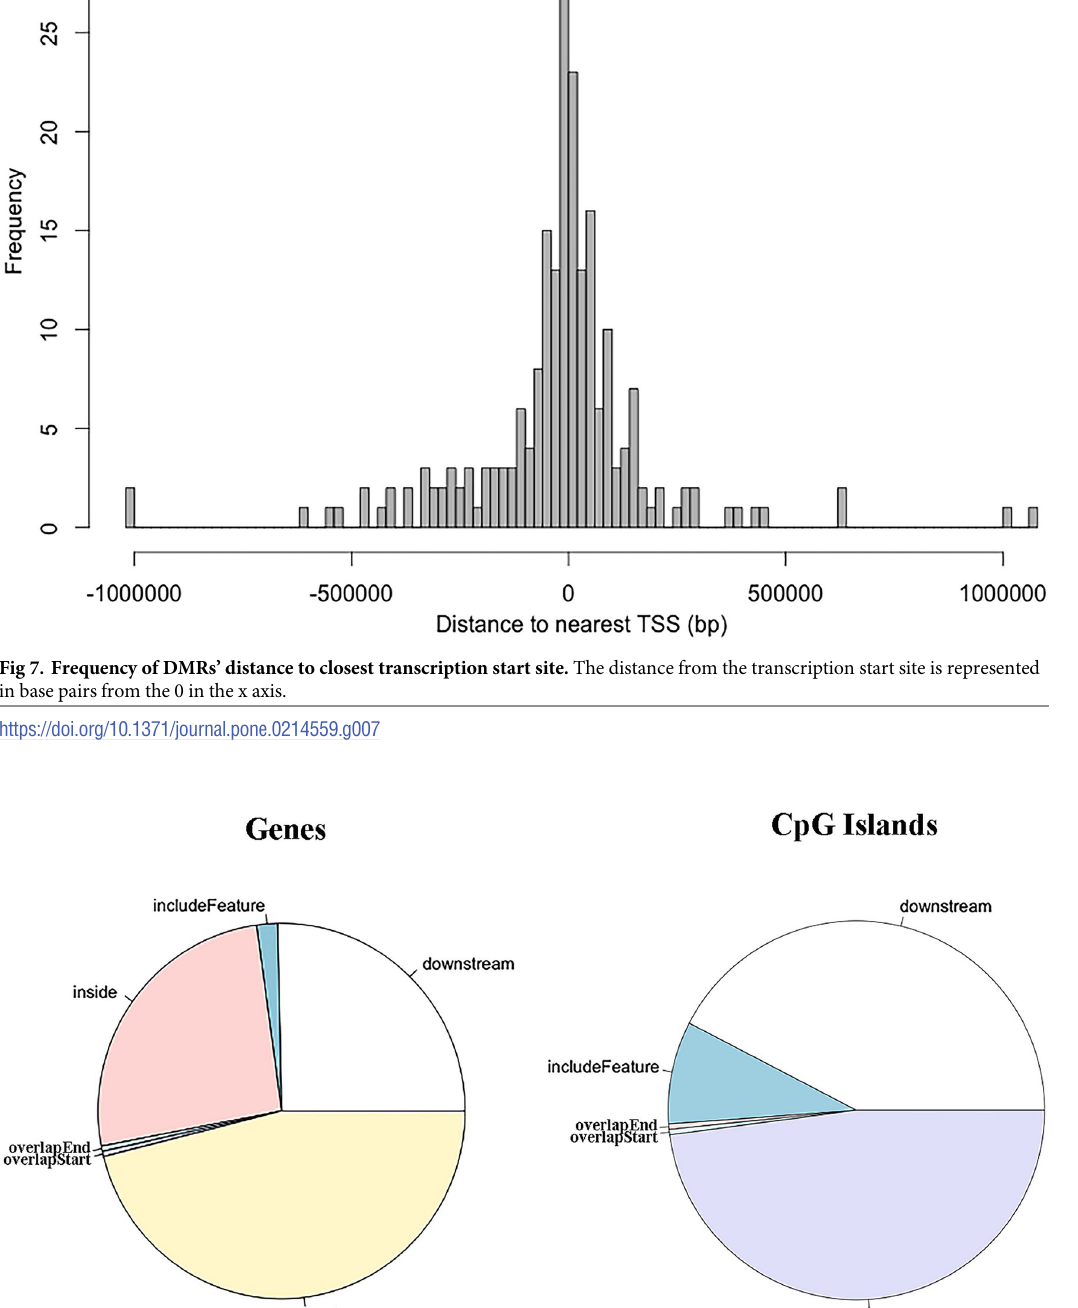
PLOS ONE | https://doi.org/10.1371/journal.pone.0214559 October 17,